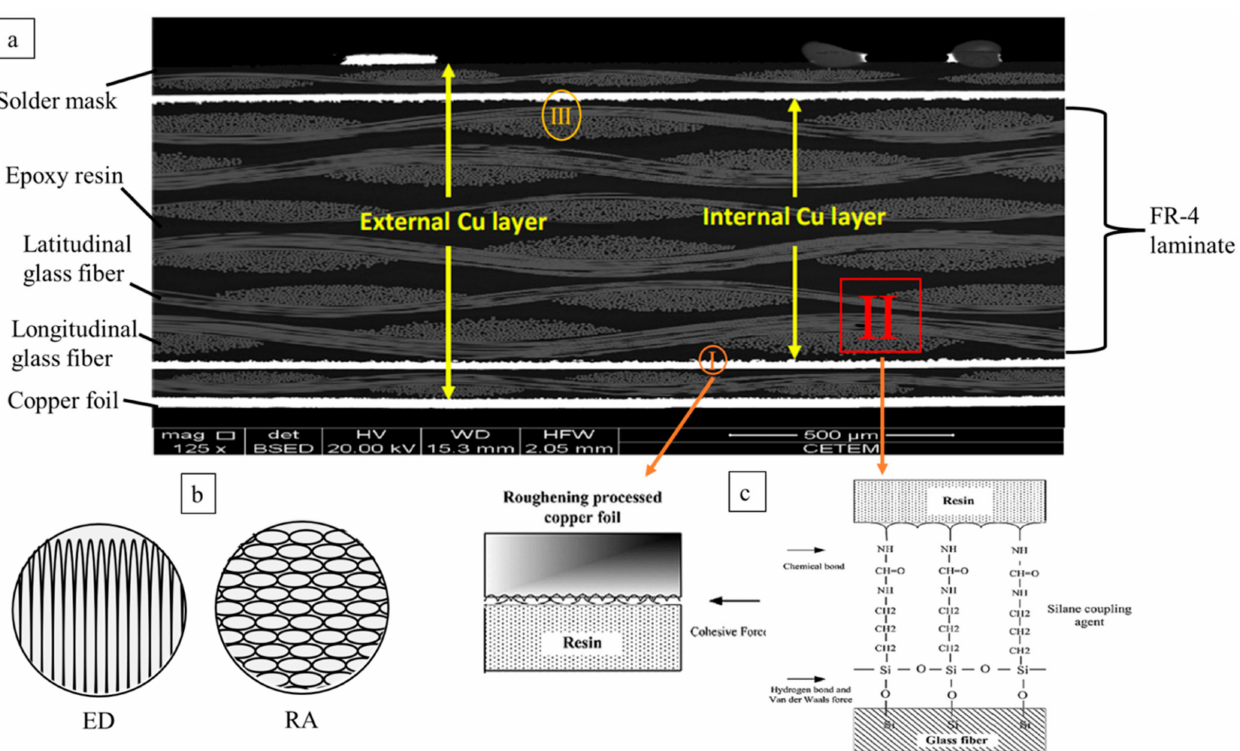
Figure 2. ( a ) Microscopic view of PCBs internal structure—Reproduced from [12] with permission from Waste Management, ( b ) grain structure of electro-deposited (ED) copper foils and rolled annealed (RA) copper foils [13], ( c ) hetero-component interfaces: (I) copper foil–epoxy resin (II) epoxy resin-glass fibre cloth interface (epoxy-GFC) (III) copper foil-glass fibre cloth interface (copper foil—GFC)—Reproduced from [14] with permission from Journal of the Air and Waste Manage- ment